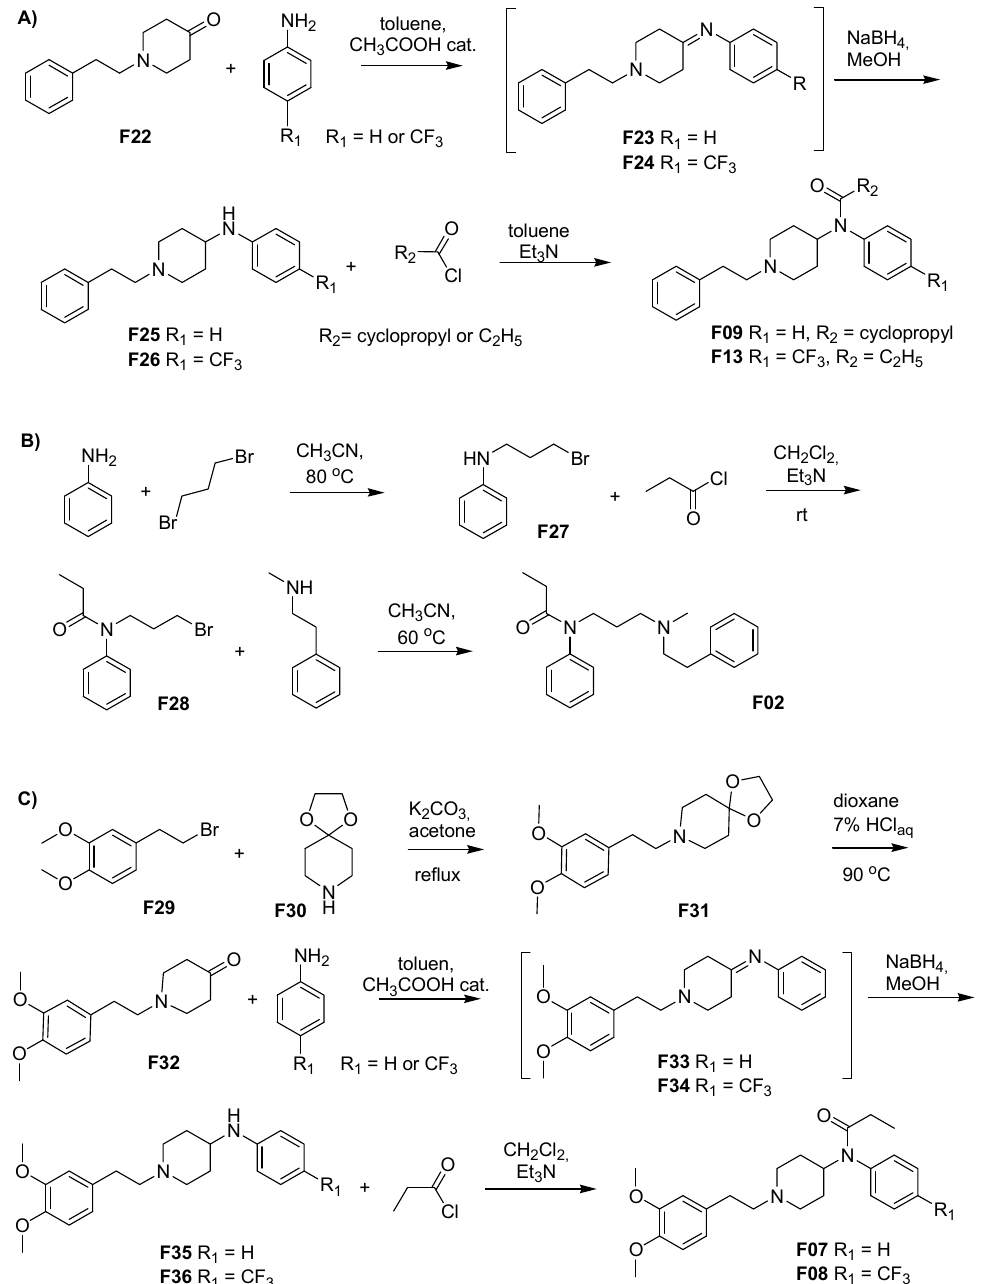
Figure 13. Syntheses of fentanyl derivatives A ) F09 and F13 , B ) F02 C ) F07 and F08 .